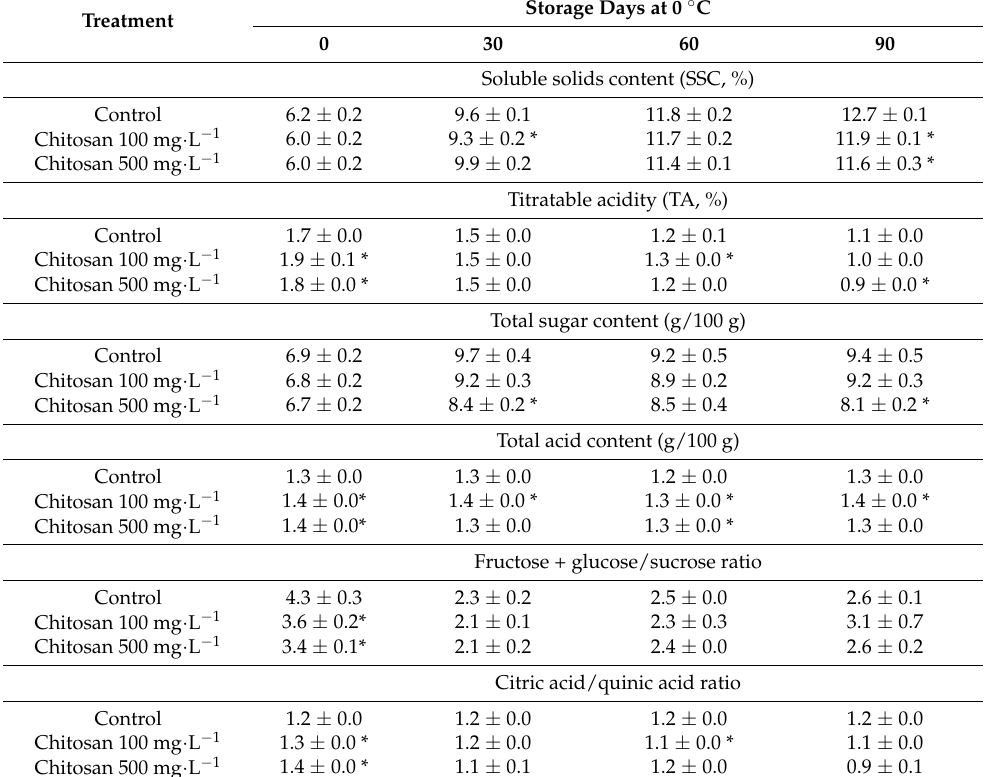
Table 3. Effects of preharvest chitosan application on soluble solids content, titratable acidity, total sugar content (HPLC analysis), total acid content (HPLC analysis), and their ratios in ‘Garmrok’ kiwifruit during cold storage. Experimental data represent means ± standard error with n = 10 (SSC) and n = 3 (titratable acidity, total sugar content, total acid content, and their ratios). *, in each column indicate significant differences between treatments at each sampling date, according to the least significant difference (LSD) test at p ≤